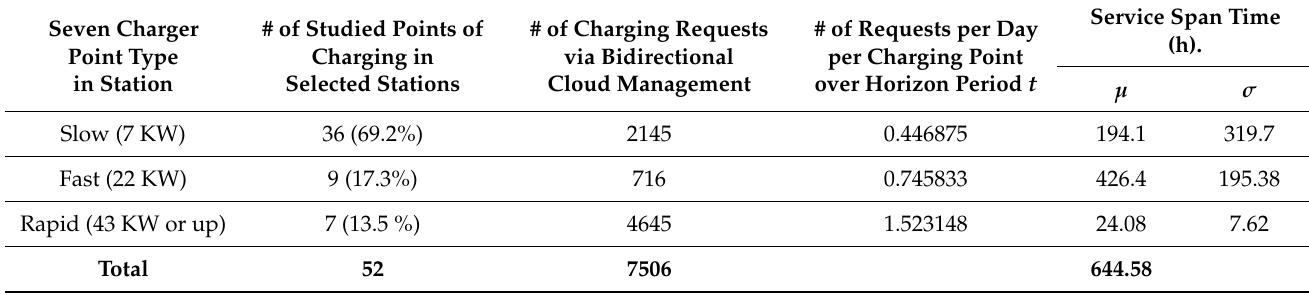
Table 6. The descriptive analysis according to training data.